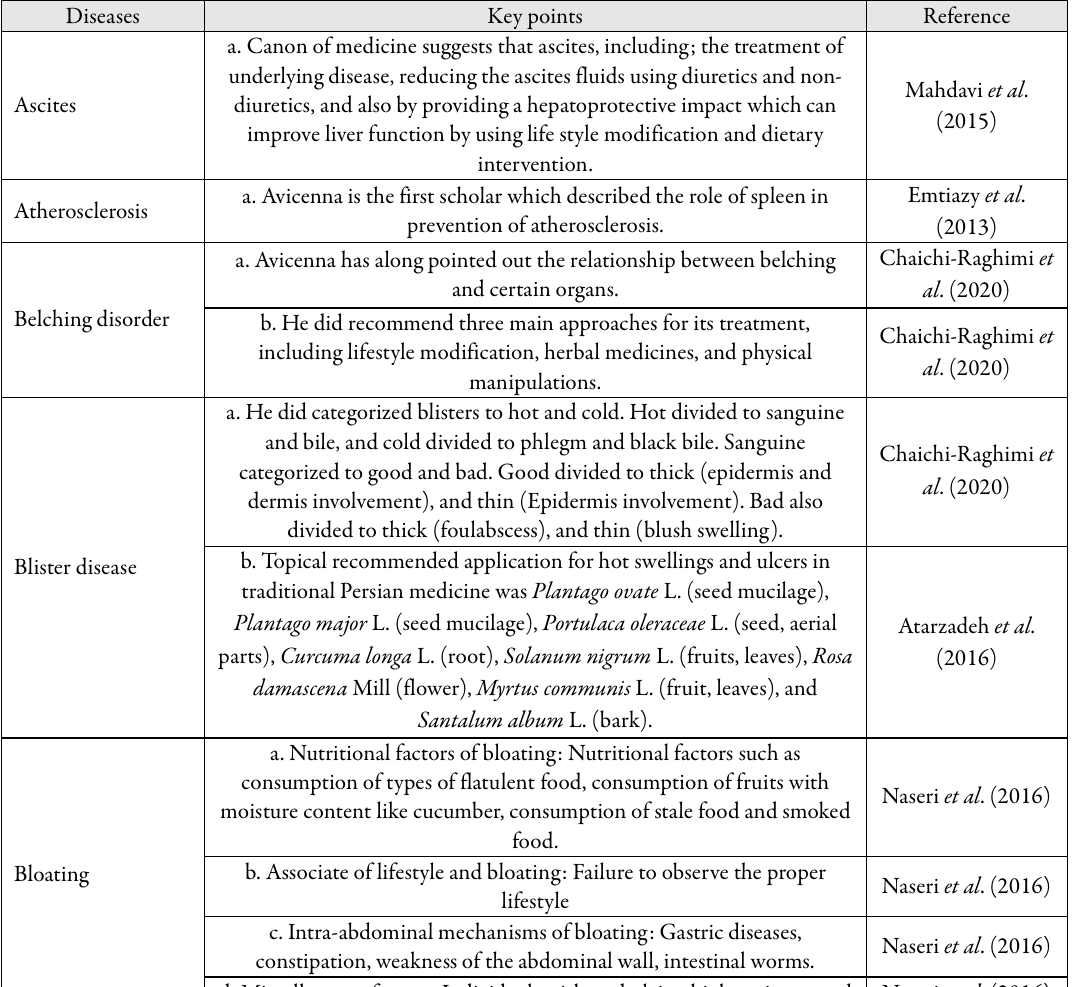
Table 5. Avicenna and his knowledge in treatment of diseases